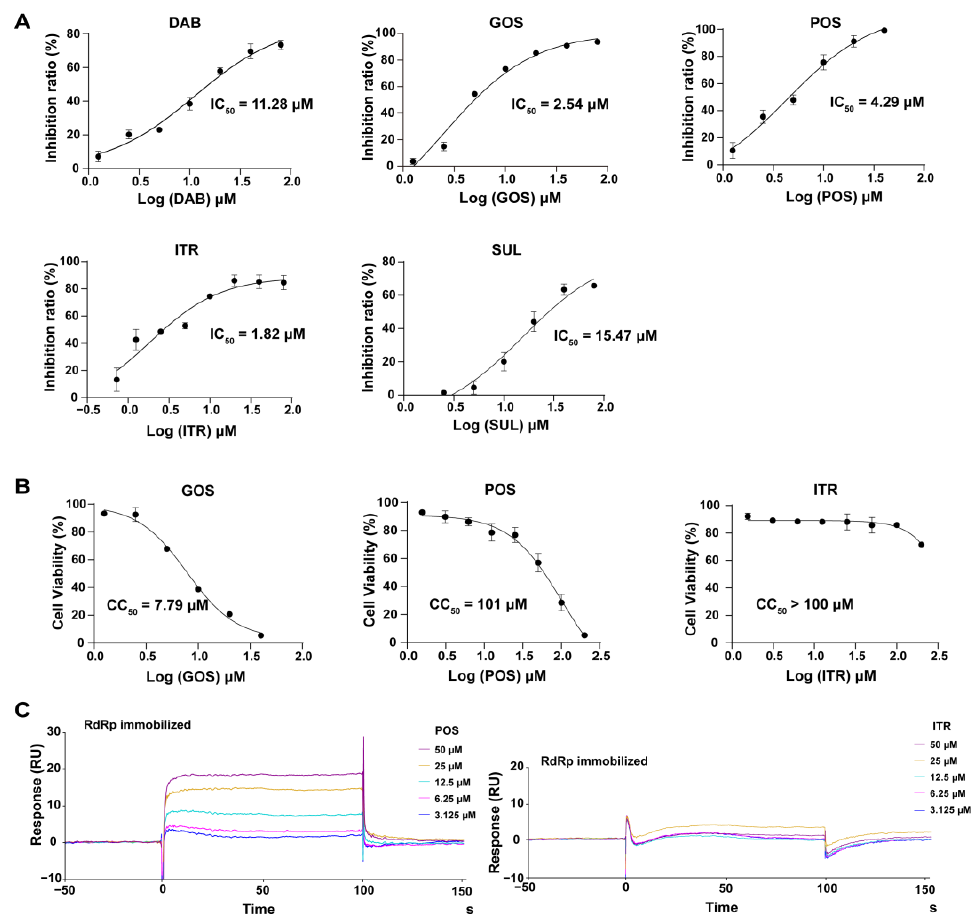
Figure 2. Biological assays of RdRp inhibitors. ( A ) The inhibitory effect of different compounds on RdRp activity. Different concentrations of DAB (1.25 – 80 μM), GOS (1.2 5 – 80 μM), POS (1.2 5 – 40